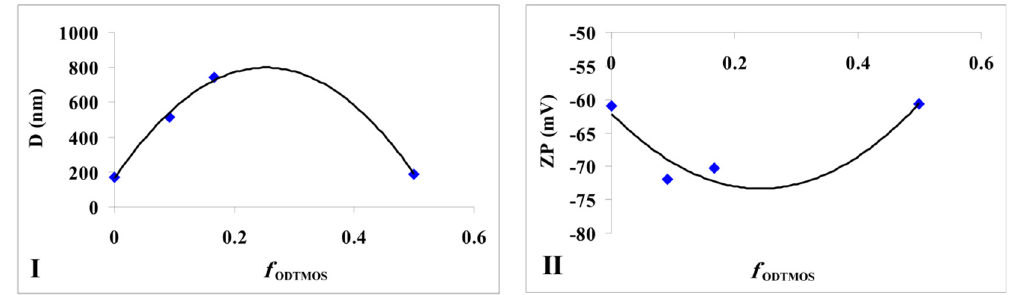
Figure 4. The modification of pH depending on the ODTMOS fraction; Inset picture : The dispersions prepared at OLA/Na 2/1 (mole/mole) and 0/1( sample H ); 1/1 ( sample A ); 1/5 ( sample G ) and 1/10 ( sample E ) (ODTMOS/SiO 2 (mole/mole)).